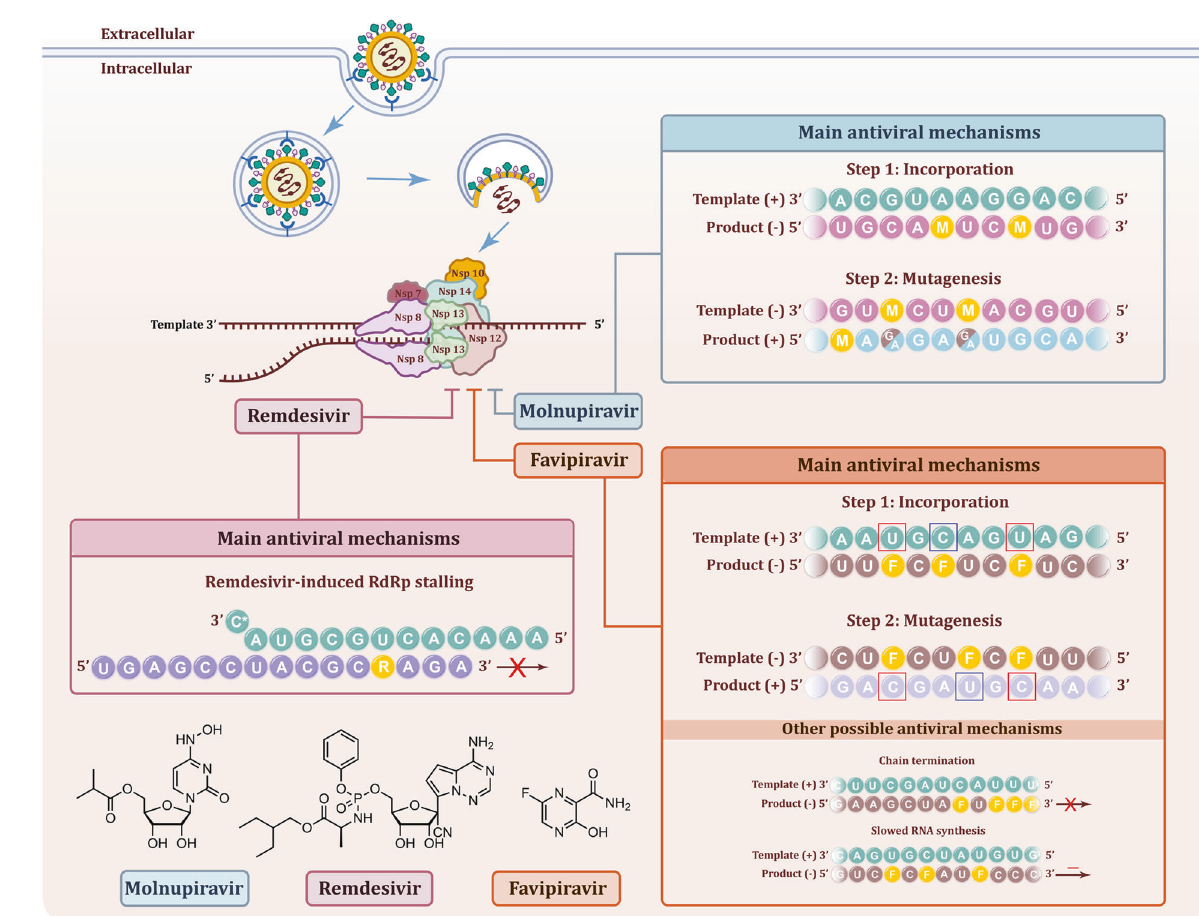
Fig. 1 Mechanisms of molnupiravir, remdesivir, and favipiravir in against SARS-CoV-2. The virus binds to the ACE2 receptor of the host cell and then be internalized. The membrane of the vacuole fuses with the virus and release the genome of the virus into the cytoplasm of the host cell. The virus genome translated and produced the RNA replicase-transcriptase complex which contains 16 NSPs. One of the NSPs, non- structural protein 12 (Nsp12) has the function of RdRp and could mediate the replication of viral genome together with other replicases. Molnupiravir, remdesivir, and favipiravir could inhibit the function of RdRp. The mechanisms were as follow: (1) Molnupiravir induced RNA mutagenesis by two steps: M nucleotides can be incorporated by RdRp into the negative-strand genomic ( − ) during copying of the positive- strand template ( + ) instead of C or U. The obtained negative-strand RNAs containing M can then be used as a template to produce mutagenized positive-strand. These RNA products are predicted to be mutated and results in nonfunctional viruses formated. RNA of random sequence is shown, with M and mutated residues indicated as yellow and brown letters, respectively. (2) Remdesivir acts as a nucleoside analog and could be incorporated into the growing RNA strand by the RdRp. The replacing of ATP with RTP leads to an elongation barrier after addition of three more nucleotides and induces RdRp stalling. RNA of random sequence is shown, with R indicated as yellow. (3) Favipiravir, a purine nucleic acid analog, could mimics the purines G and A to form non-canonical base pairs and has also been found to act against coronaviruses via other mechanisms, including non-obligate chain termination and slowing of RNA synthesis. RNA of random sequence is shown, with F indicated as yellow. The mutated residues are marked with blue or red